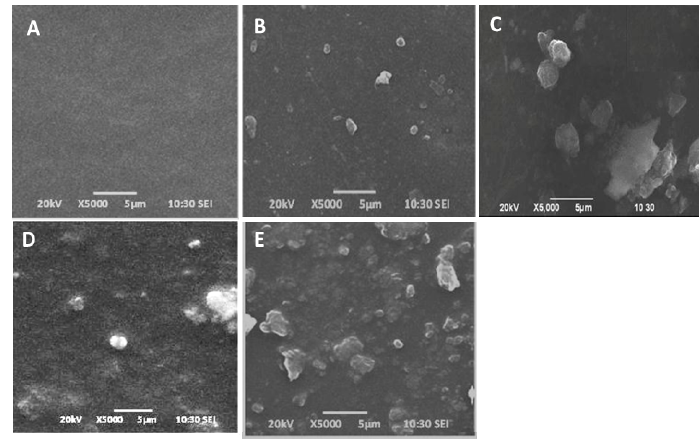
Figure 5. SEM images of virgin PMMA film ( A ) and the composites CK 1 PNC ( B ), CK 3 PNC ( C ), CK 5 PNC ( D ), and CK 10 PNC ( E )